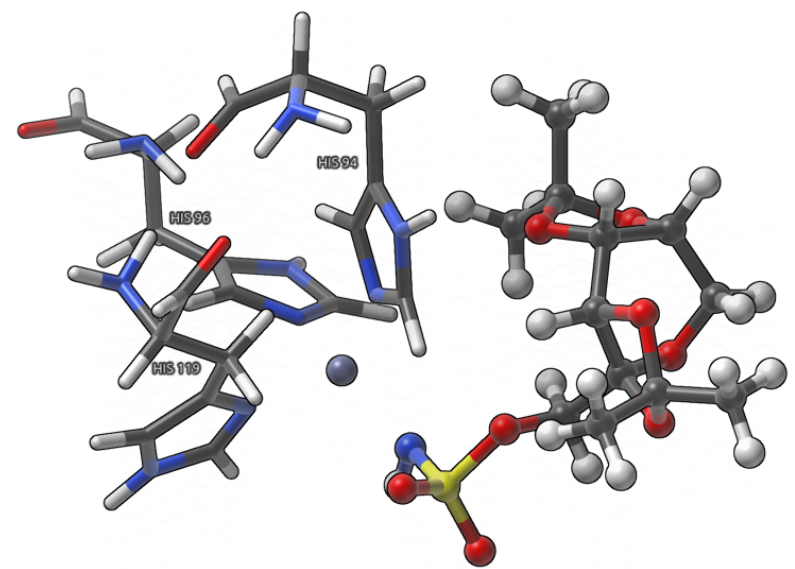
Figure 3. Graphical representation of the small model used in the study. Amino acids coordinating the metal ion are presented using licorice visualization, whereas the ligand—Topiramate as CPK model. Color coding: white—hydrogen, grey—carbon, red—oxygen, blue—nitrogen, yellow—sulfur, and purple—zinc.